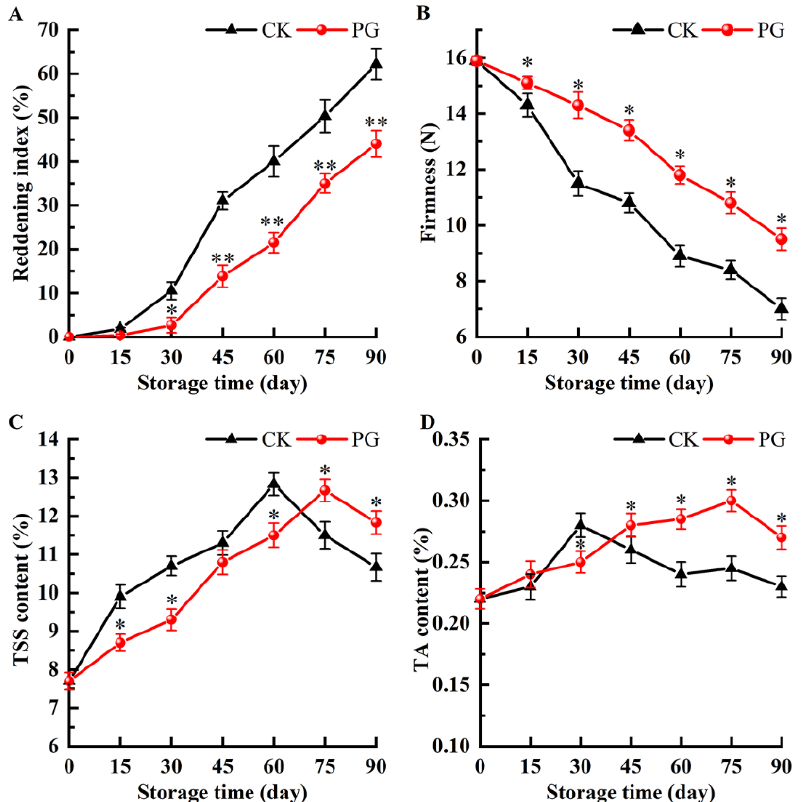
Figure 2. Effects of PG treatment on reddening index ( A ), firmness ( B ), total soluble solids (TSS) ( C ), and titratable acid (TA) ( D ) of winter jujube fruits. Vertical bars represent the SE of the mean. The asterisks indicate significant difference between two treatments during the same storage period (* p < 0.05, ** p < 0.01).